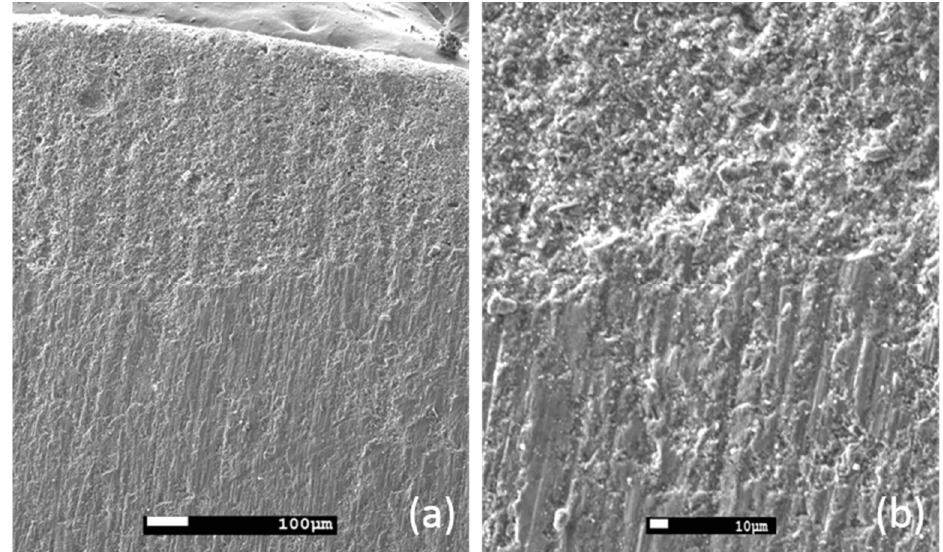
Figure 1. SEM micrograph of the coated concrete specimen at the interface region: magnification ( a ) × 60, ( b ) × 200.